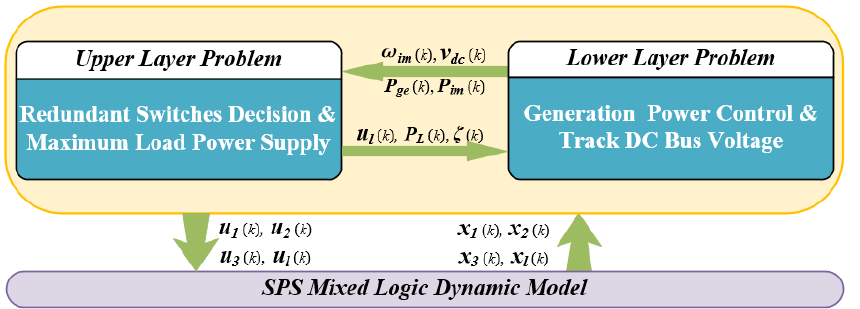
Figure 2. Flowchart of optimal management algorithm for